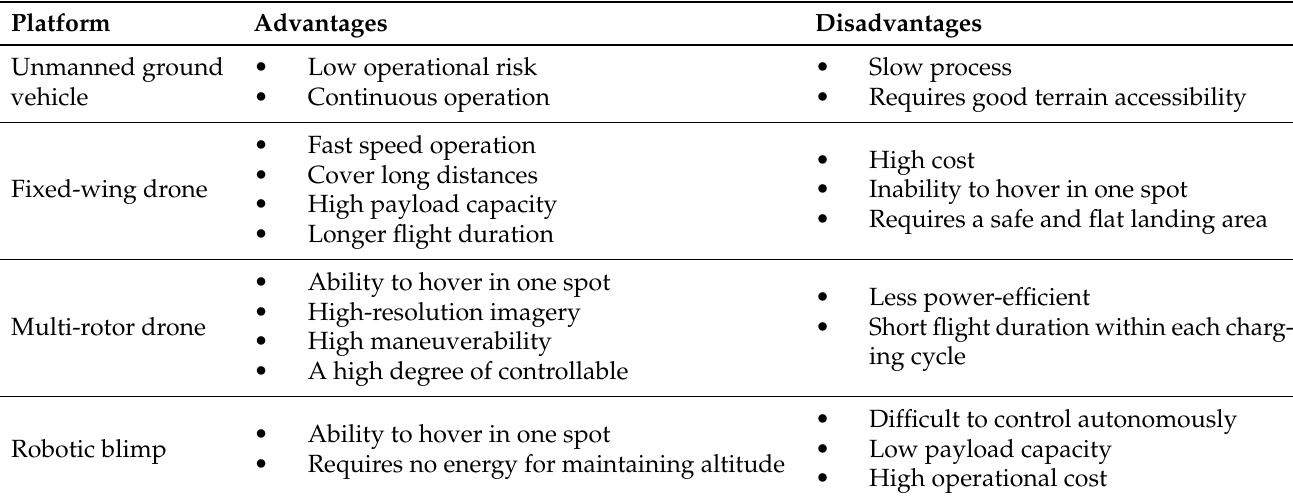
Table 1. Comparison of common unmanned inspection